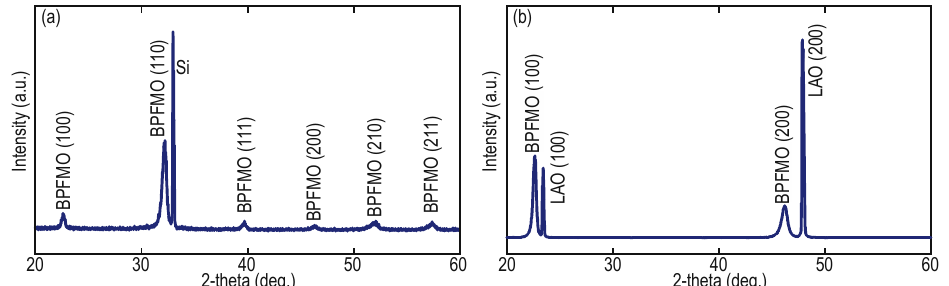
Figure A2. ( a ) XRD pattern of (Bi 0.95 Pr 0.05 )(Fe 0.95 Mn 0.05 )O 3 /Si sample indexed by a R3m (pseudocubic) structure. The BPFMO film exhibits weakly preferred Bragg diffraction in the (110) direction. ( b ) XRD pattern of (Bi 0.95 Pr 0.05 )(Fe 0.95 Mn 0.05 )O 3 /LaAlO 3 sample. The BPFMO film exhibits strongly preferred Bragg diffraction in the (100) direction.